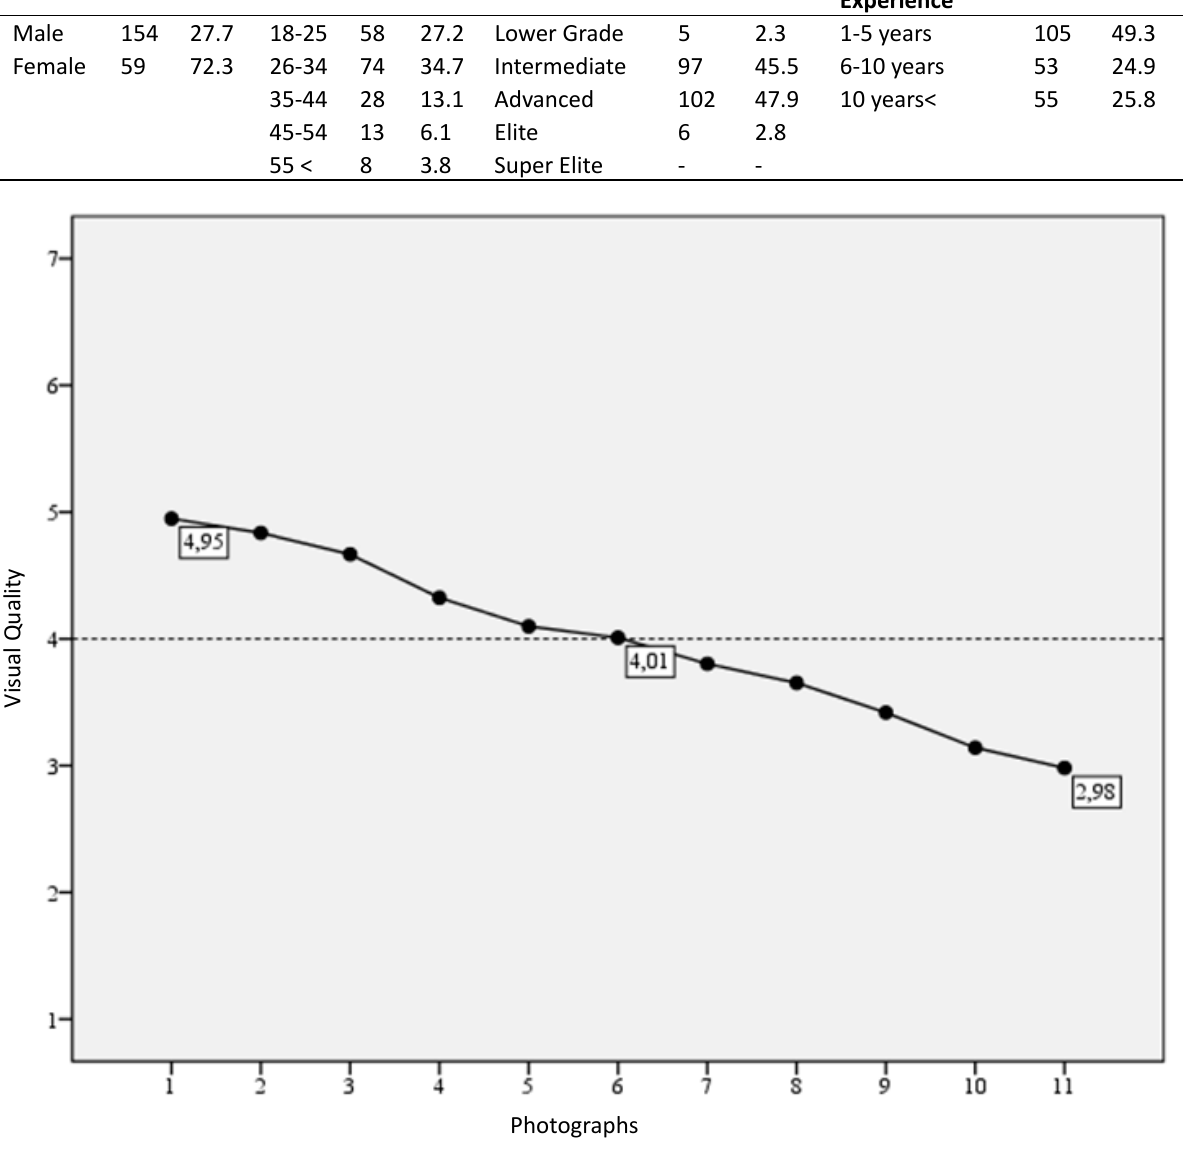
Figure 1. Curve of photographic visual quality of participants (Chalk density